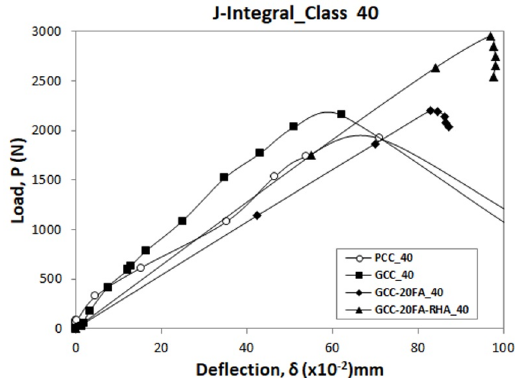
Figure 11. Average values of load-deflection curves in the middle of the span of the class 40 notched beams of different matrices.